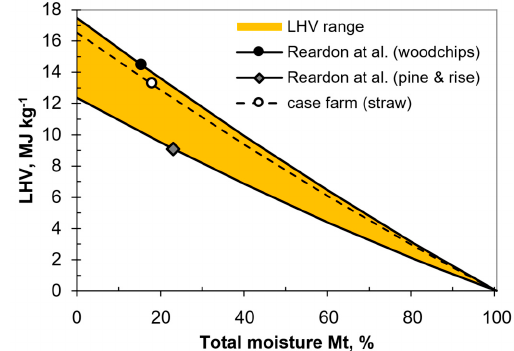
Energies 2019 , 12 , x FOR PEER REVIEW Figure 2. Lower heating value of manure from the litter system. Figure 2. Lower heating value of manure from the litter system. Figure 2. Lower heating value of manure from the litter system.